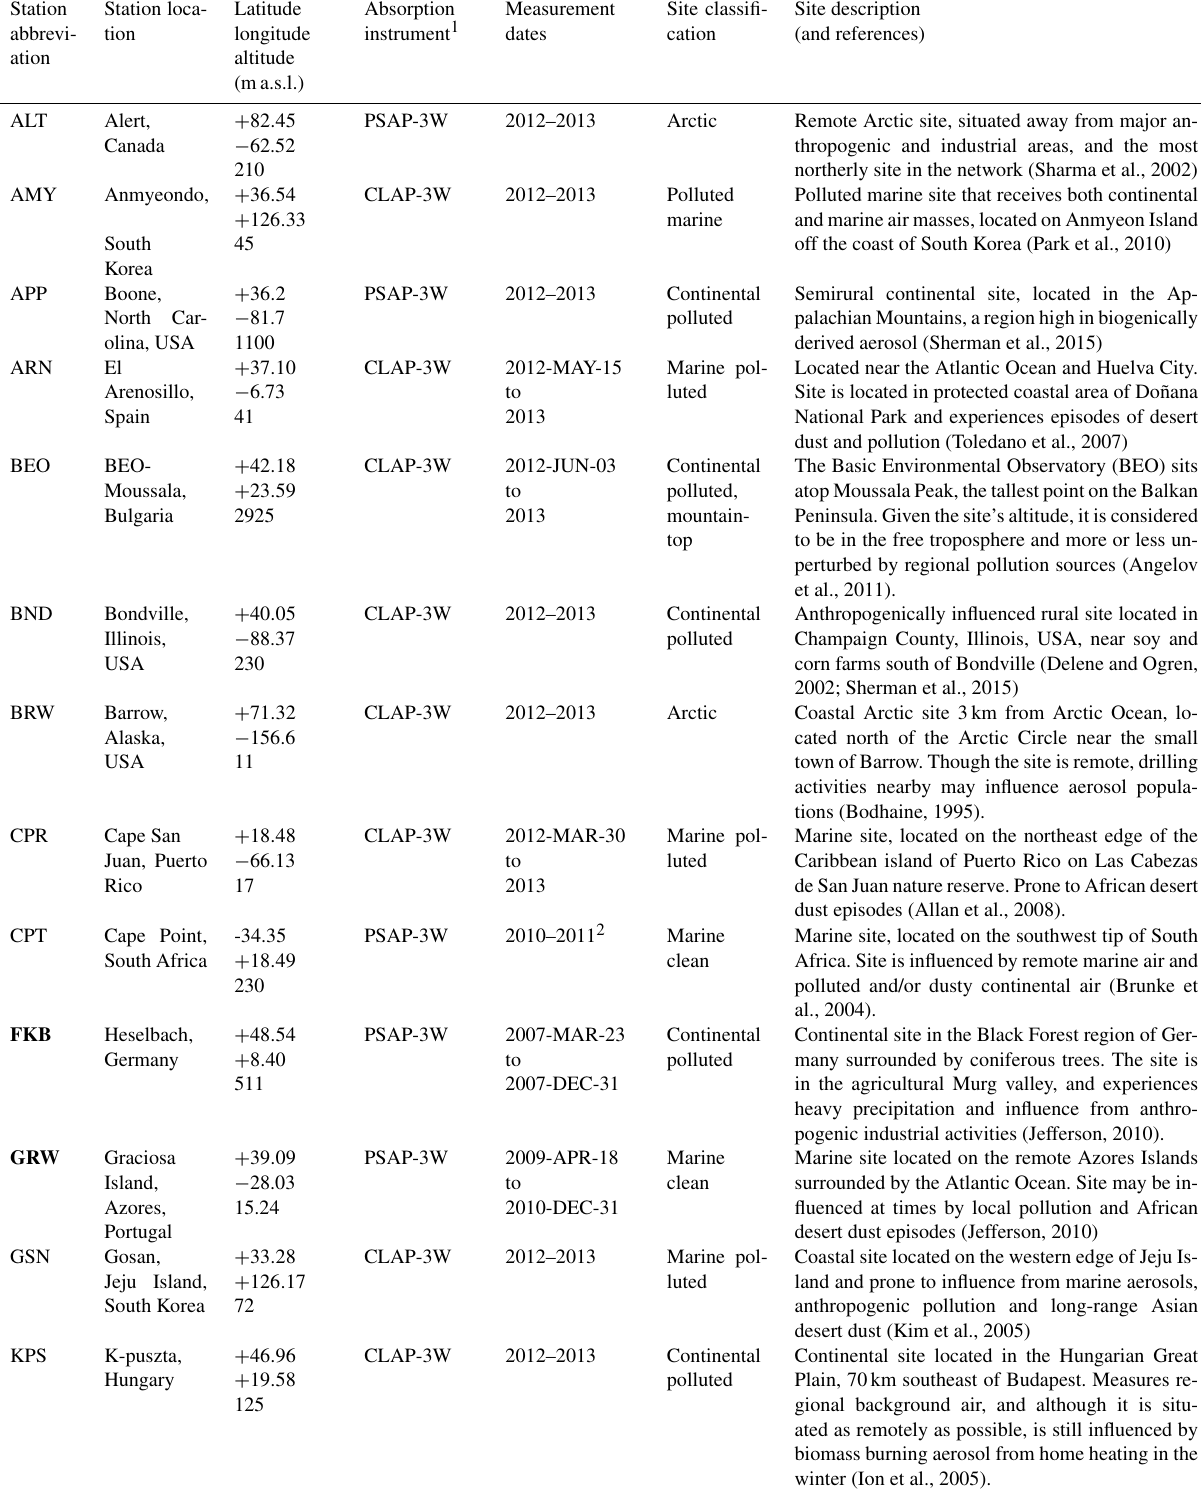
Table 2. Monitoring site locations and descriptions. Stations in bold indicate stations that are part of the ARM Mobile Facility (AMF) program and are temporary measurement sites.